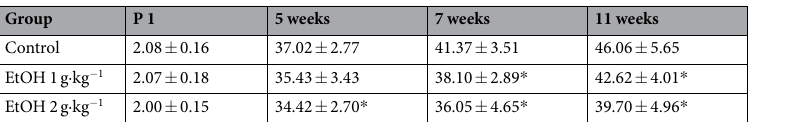
Table 2. Body weight change of offspring prenatally exposed to ethanol (EtOH). * P < 0.05, n =